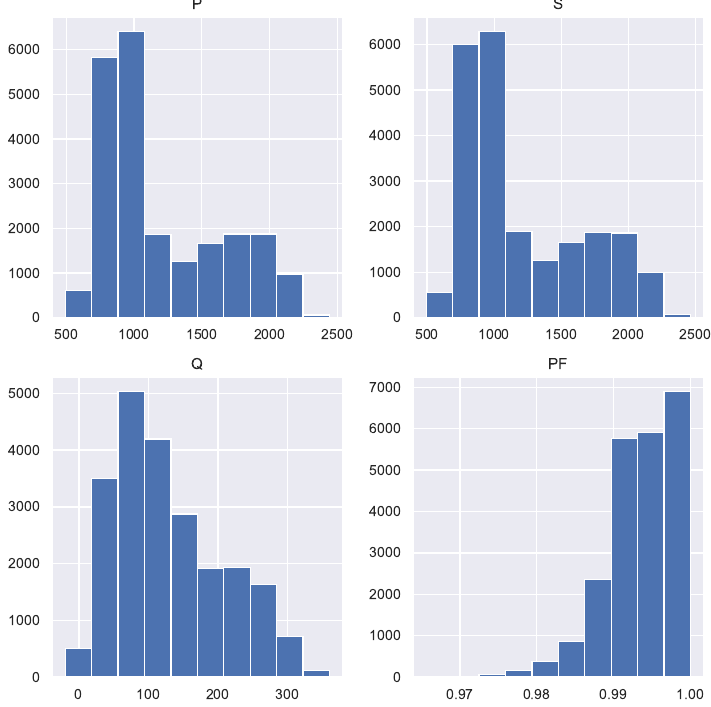
Figure 16. Histograms of the extended variables in Scenario